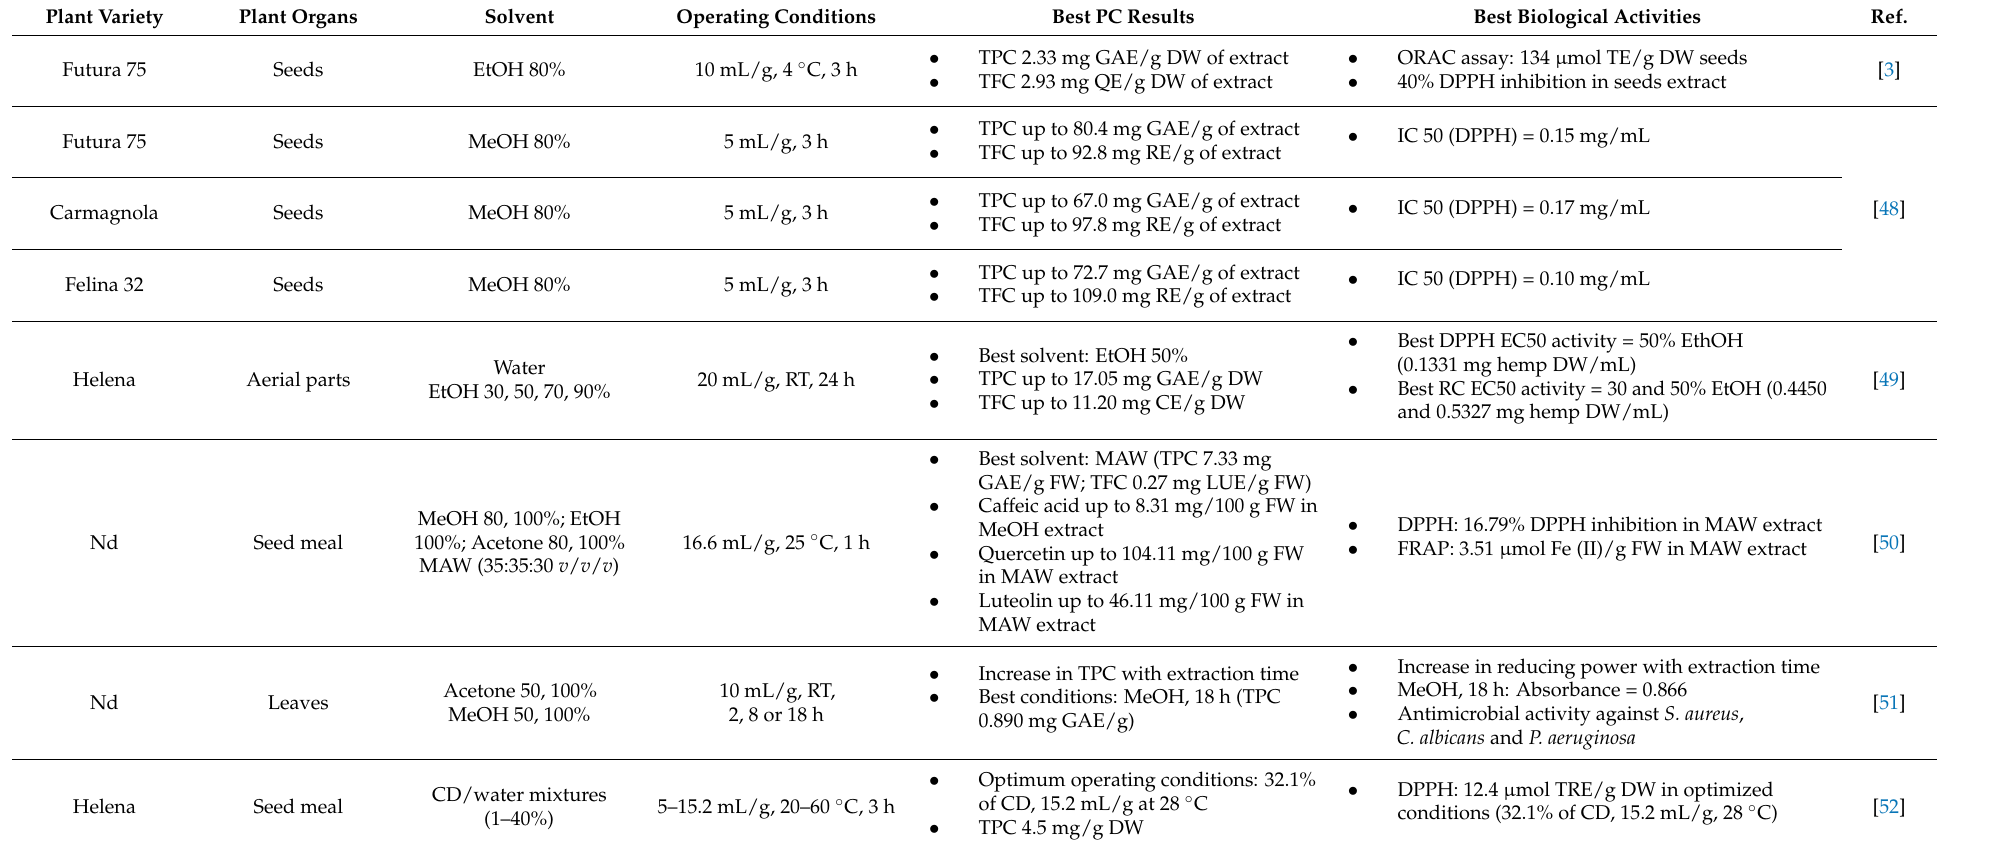
Table 1. Studies using conventional solvent extraction for the recovery of PC from